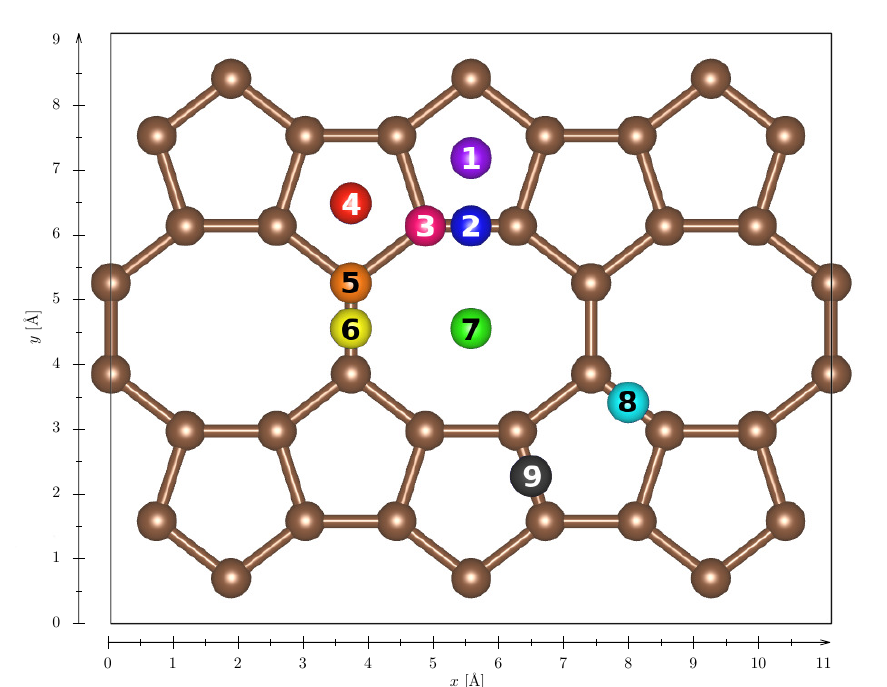
Figure A1. Schematic view of adsorption sites on POP-graphene. The colored balls represent the adsorption sites, where the number inside represents the sites’ index. The interaction energies E ( 1 ) − ( 9 ) were calculated for all three (x, y and z) alignments of the H 2 molecule axis. int ,POP-graphene + H 2 The data is presented in Figure